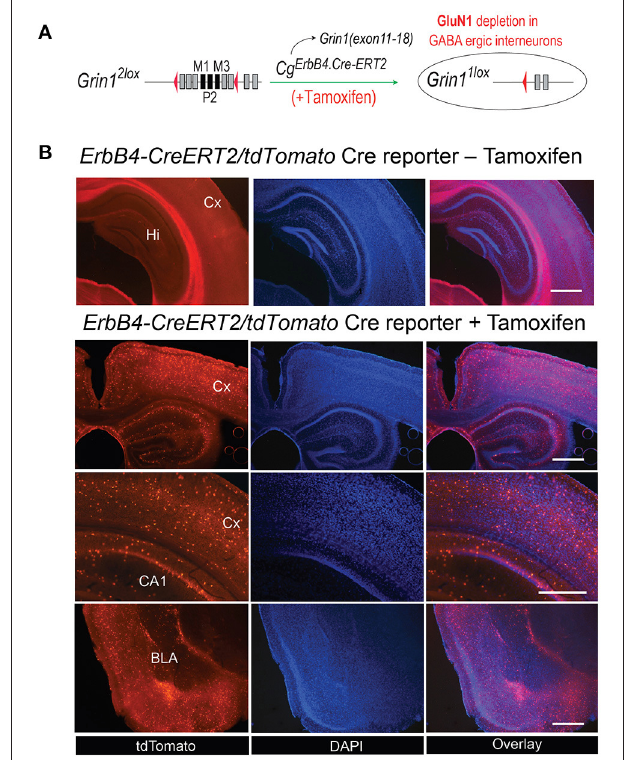
FIGURE 1 | (A) Generation of Grin1 1 erbb 4 mice and Cre-activirty in ErbB4 expressing cells. Schematic for the ErbB4-ERT2Cre-mediated deletion in Grin1 f / f mice. (B) The tamoxifen-induced expression pattern of the Cre-dependent tdTomato in B6. Cg Erbb 4 tm 1.1( cre / ERT 2) Aibs / J / Gt ( ROSA ) 26Sor tm 14( CAG − tdTomato ) Hze was evaluated in coronal brain sections of Tamoxifen-injected and in naive mice 3 weeks after Tamoxifen injection by the tdTomoto fuorescence in the DAPI stained section. Scale bars 1.0mm, Hi, Hippocampus; Cx, Cortex; BLA, Basal lateral